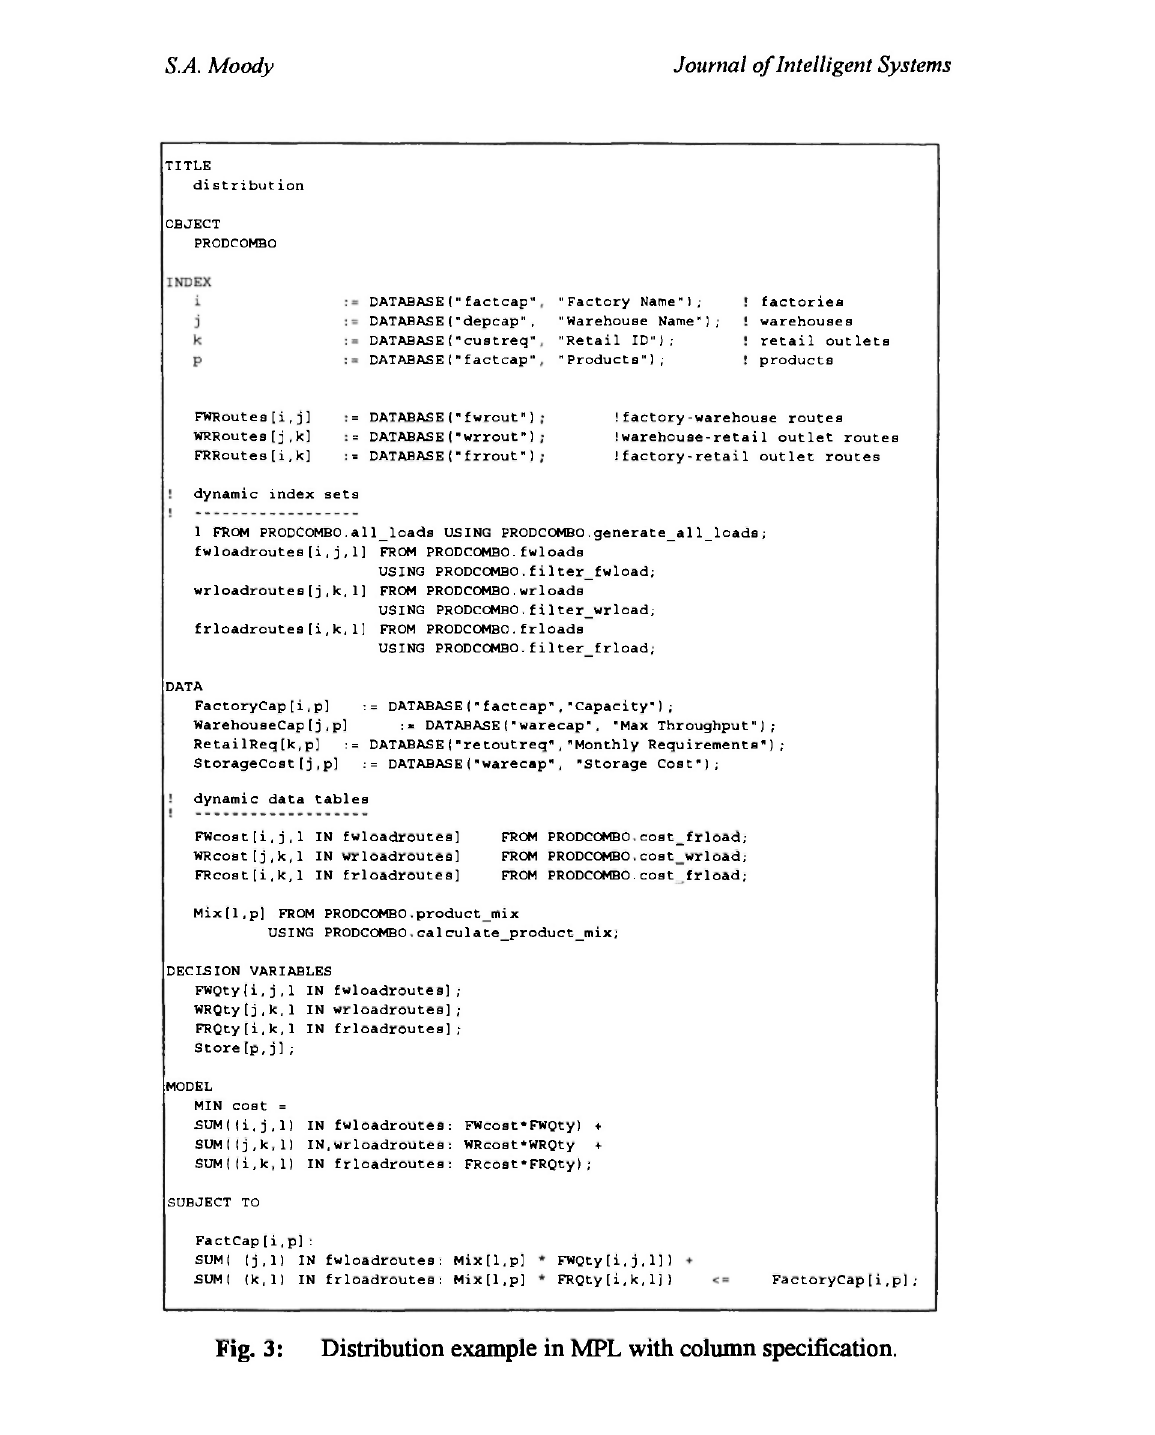
Fig. 3: Distribution example in MPL with column